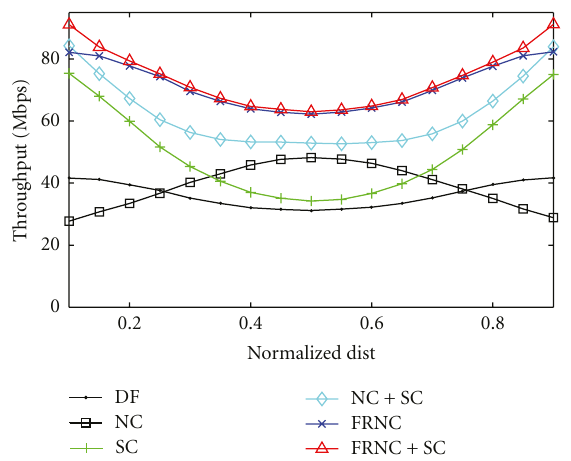
Figure 7: Throughput achieved by di ff erent schemes on the broad- cast channel-e ff ect of relay position for two way relay (simulation results, largest constellation is 256 QAM).